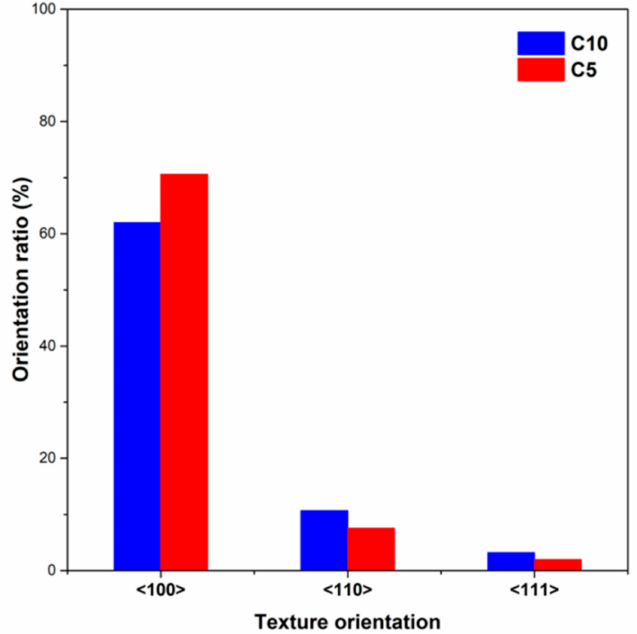
Figure 4. Texture ratio of as-built Cr components with long scan length (C10) and short scan length